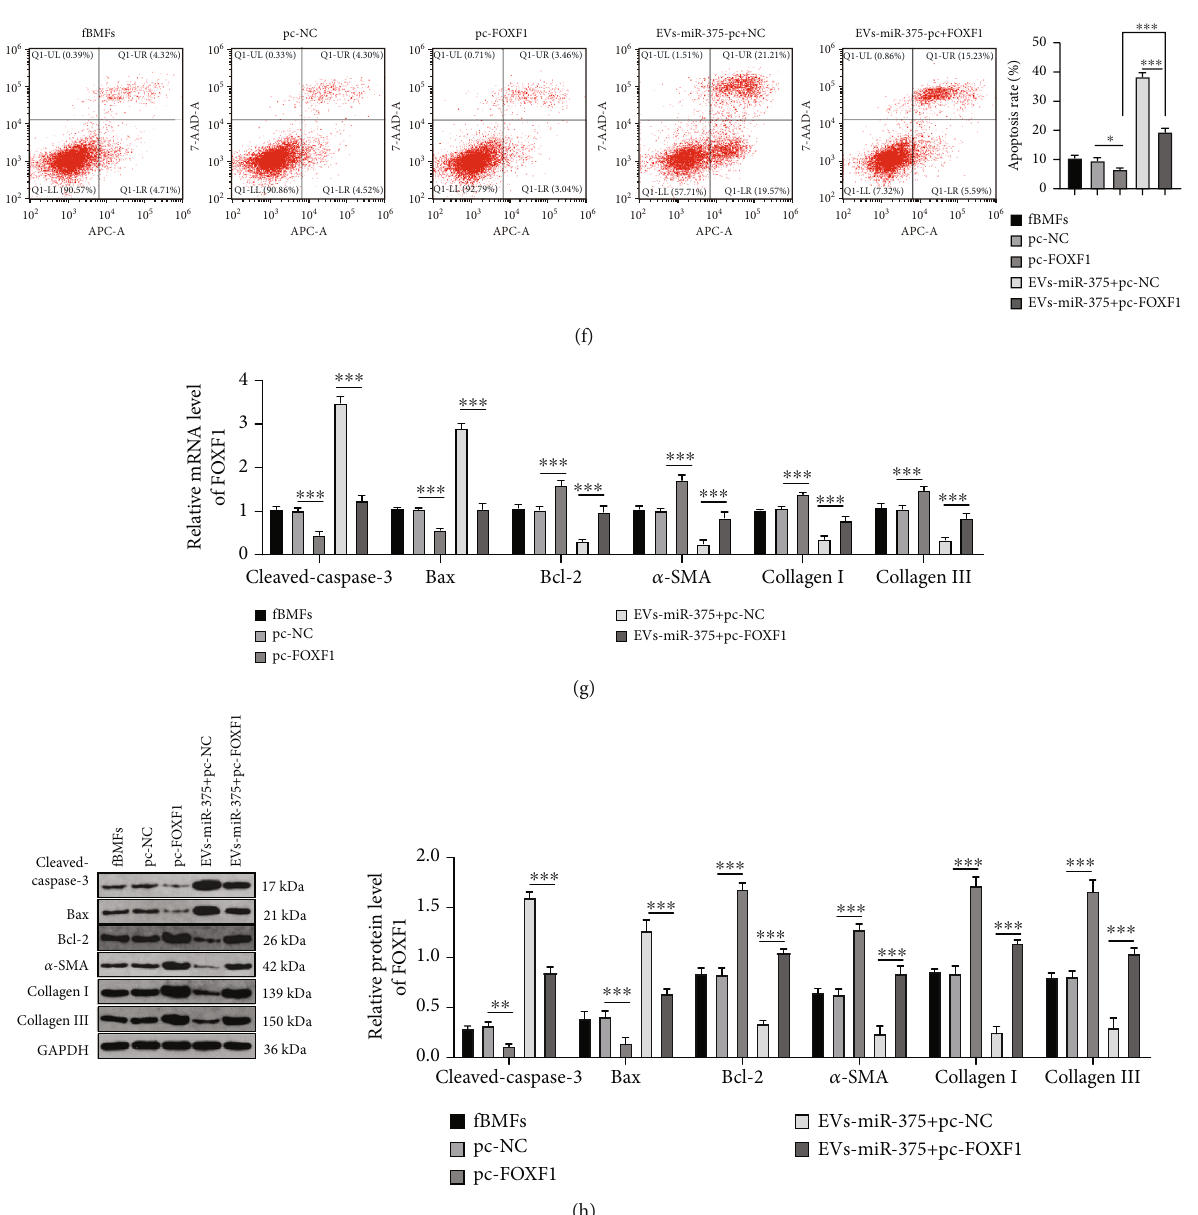
Figure 6: EV-carried miR-375 inhibits the fi brosis of fBMFs via targeting FOXF1. EVs-miR-375 and plasmid overexpressing FOXF1 (pc- FOXF1)/pc-NC were transfected into fBMFs. (a, b) The successful transfection of FOXF1 was veri fi ed using RT-qPCR and WB. (c) CCK-8 assay was used to detect the proliferation of fBMFs. (d, e) Transwell assay was used to detect the migration and invasion of fBMFs. (f) Flow cytometry was used to detect the apoptosis of fBMFs cells. (g, h) RT-qPCR and WB were used to detect the levels of proapoptotic proteins (cleaved-caspase-3 and Bax), antiapoptotic protein Bcl-2, and fi brosis markers ( α -SMA, collagen I, and collagen III). pc-NC/pc- FOXF1: fBMFs transfected with pc-NC/pc-FOXF1; EVs-miR-375+pc-NC/EVs-miR-375+pc-FOXF1: combined treatment of EVs-miR-375 and pc-NC/pc-FOXF1 in fBMFs. The experiment was repeated 3 times, and the data were expressed as mean ± SD . Comparison among groups was analyzed using one-way ANOVA, followed by Tukey ’ s multiple comparisons test. ∗∗ P < 0 : 01 and ∗∗∗ P < 0 : 001